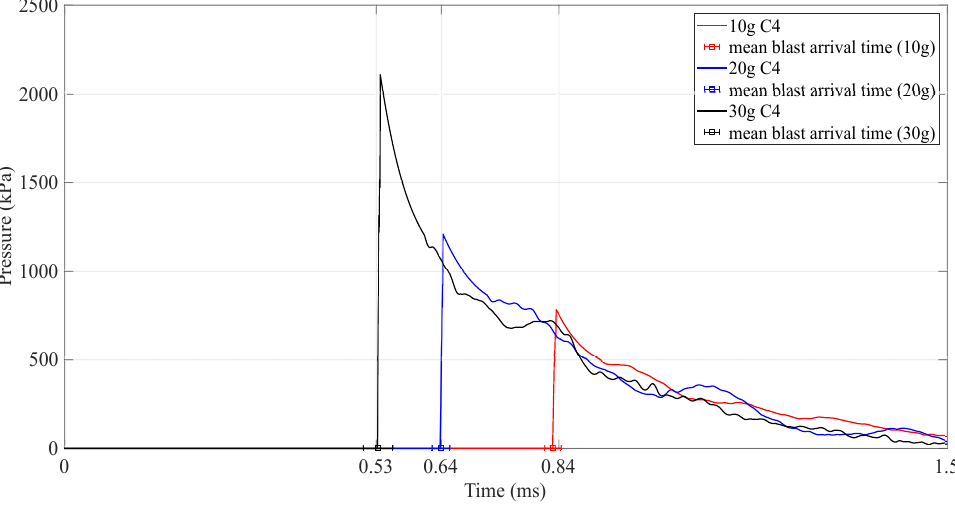
Figure 9. Average of the filtered signals of the pressure profiles for the 10, 20, and 30 g C4 charge masses and variability of the blast arrival time to the tube’s